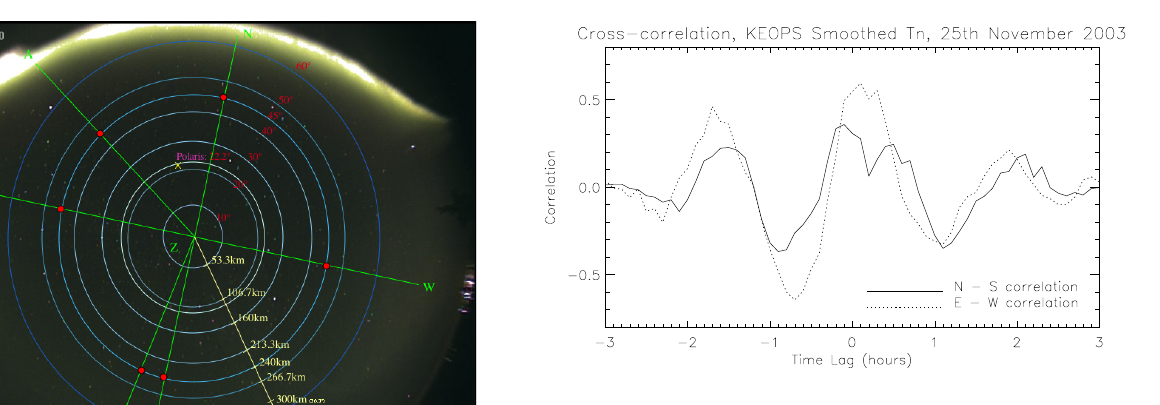
Fig. 10. Cross correlations between north and south (solid line) and east and west (dotted line) smoothed neutral temperatures from KEOPS on the 25 November